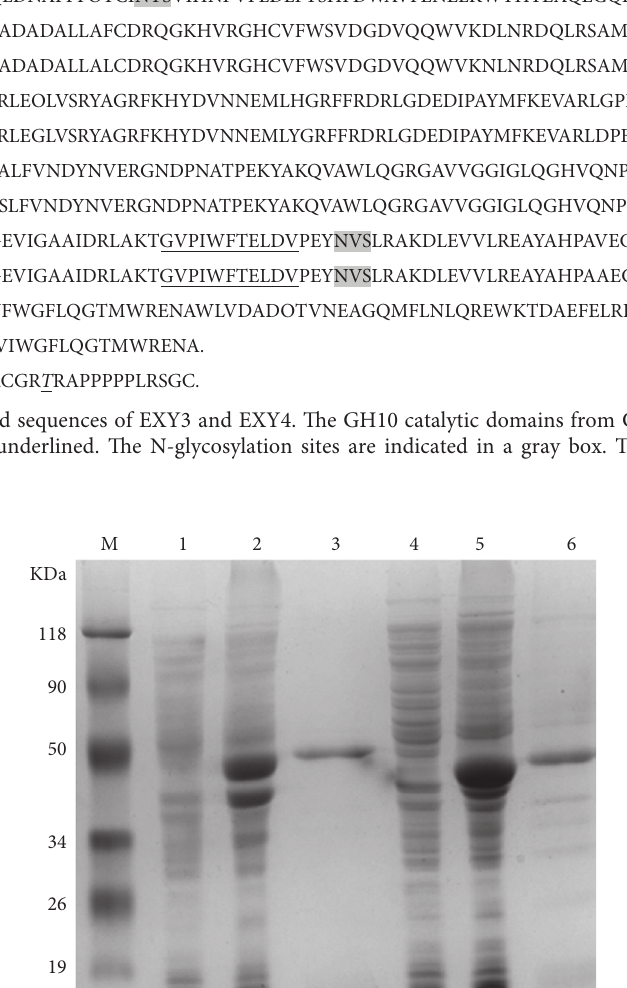
MHHHHHH SS GLVPROSOMKE T AAAKFERQHMDSPDLGTDDDDKAMADIM QLDNAFPFGTCINTSVIHNPVFLDFFTNHFDWAVFENELKWYHTEAQQGQLN QLDNAFPFOTCINTSVIHNPVFLDLFTSHFDWAVFENELKWYHTEAQEGQLN YADADALLAFCDRQGKHVRGHCVFWSVDGDVQQWVKDLNRDQLRSAMQ